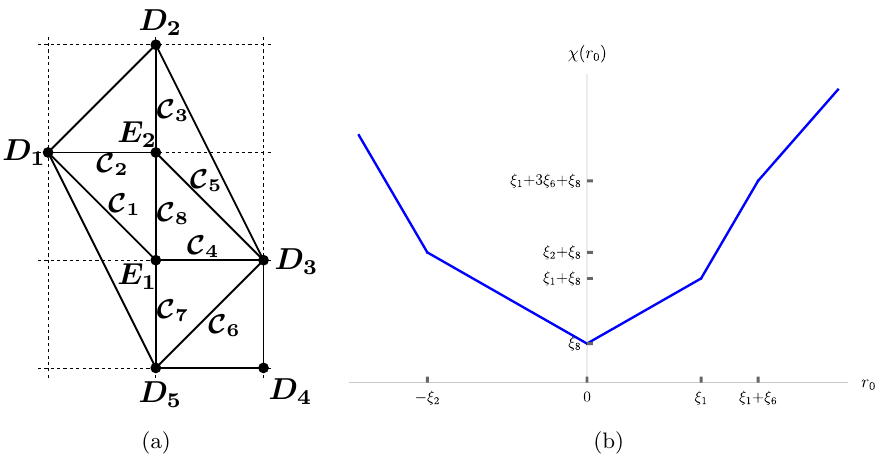
Figure 23 . Resolution (c) of the E 22 ; 1 2 singularity and its vertical